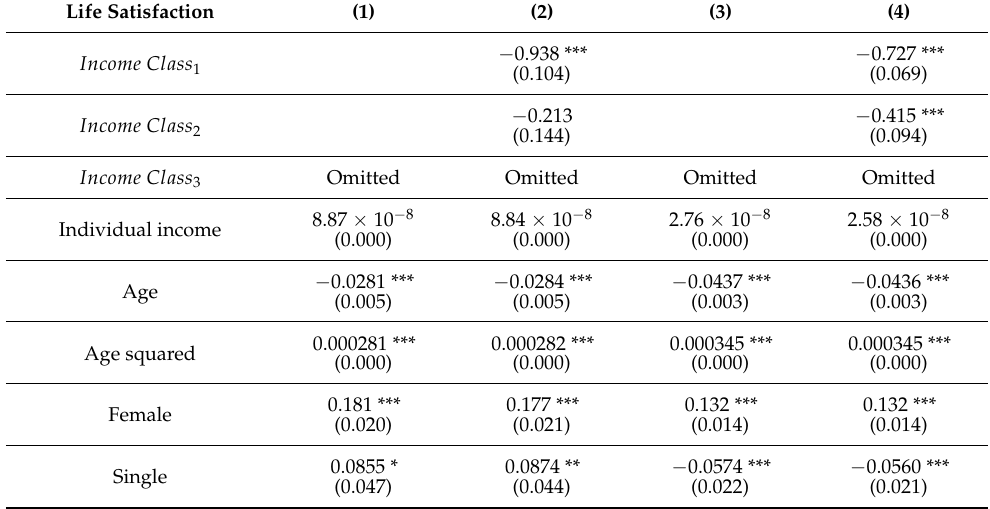
Table 3. OLS results: income classes and life